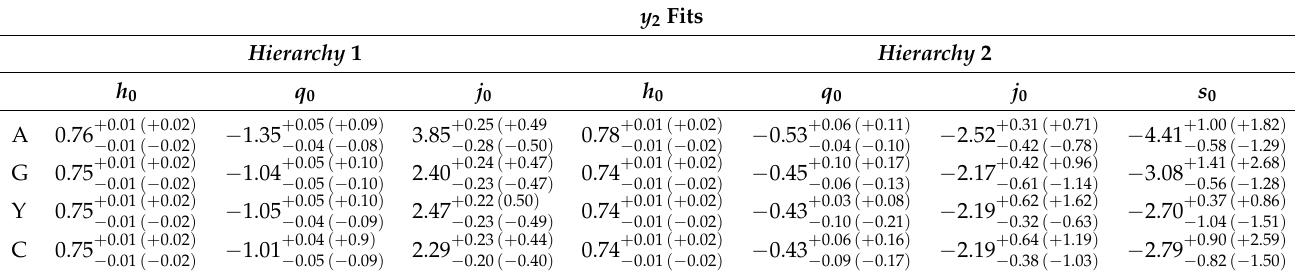
Table 4. Cosmographic best fits and 1– σ (2– σ ) errors from expansions with y 2 labeled as hierarchy 1 ( h 0 , q 0 , j 0 ) and hierarchy 2 ( h 0 , q 0 , j 0 , s 0 ). Letters A, G, Y, and C indicate Amati, Ghirlanda, Yonetoku, and Combo correlations, respectively.